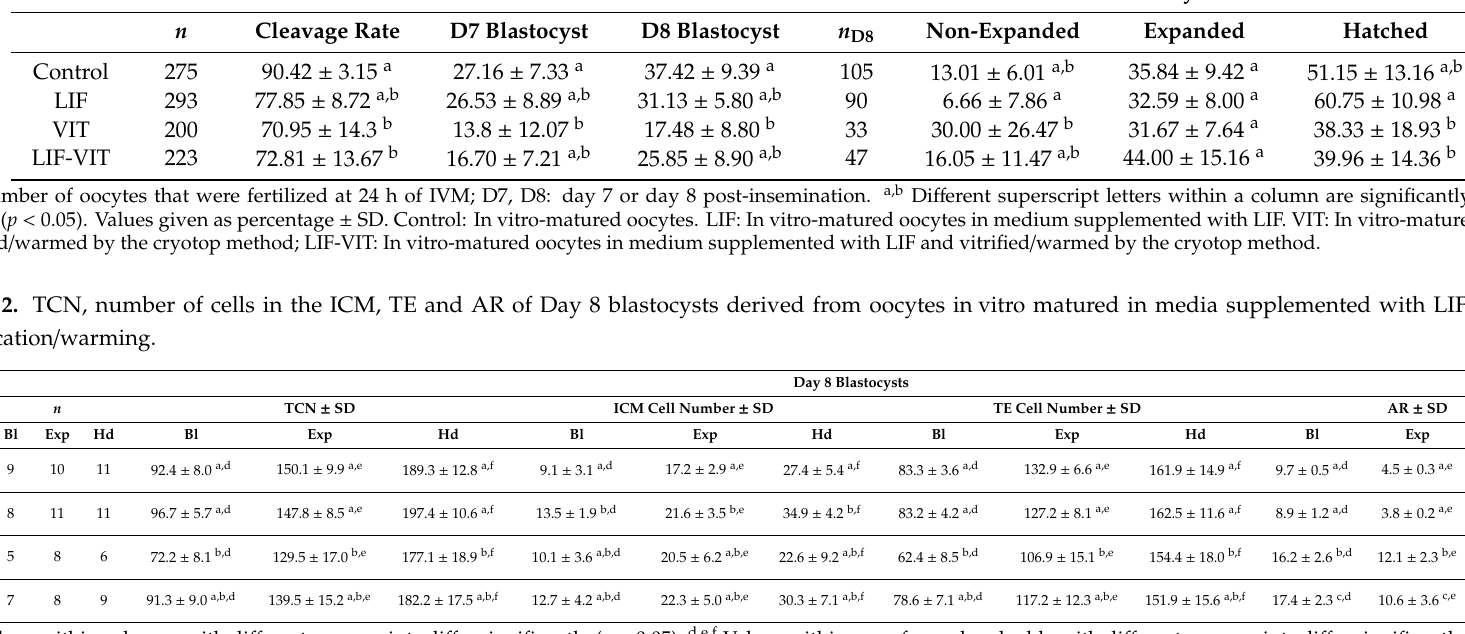
a,b,c Values within columns with di ff erent superscripts di ff er significantly ( p < 0.05); d,e,f Values within rows for each valuable with di ff erent superscripts di ff er significantly ( p < 0.05). Data shown as mean ± SD. Control: In vitro-matured oocytes. LIF: In vitro-matured oocytes in medium supplemented with LIF. VIT: In vitro-matured oocytes vitrified / warmed by